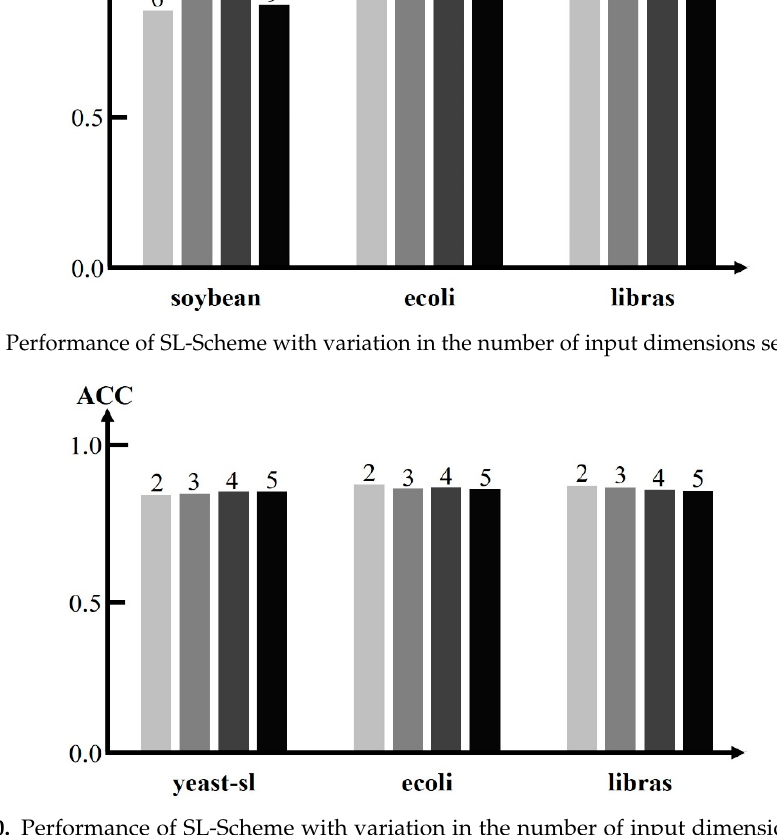
Figure 10. Performance of SL-Scheme with variation in the number of input dimensions extracted by LDA.